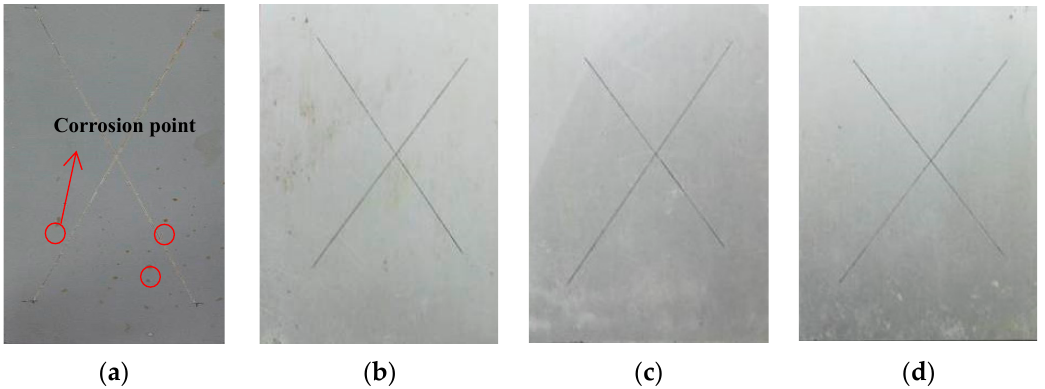
Figure 8. Salt spray results for 2024 Al-alloy samples coated Coating A ( a ); Coating B ( b ); Coating C ( c ); Coating D ( d ) after 1000 h.